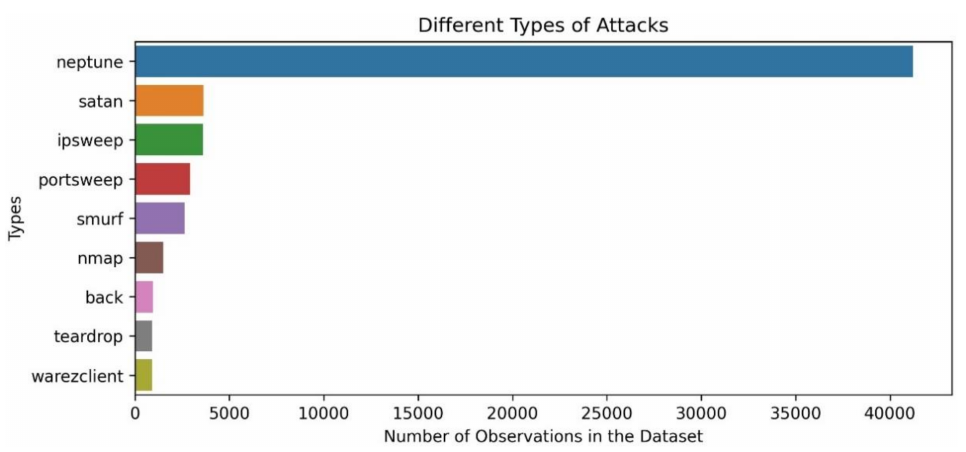
Figure 3. Different types of attacks included in the NSL-KDD dataset